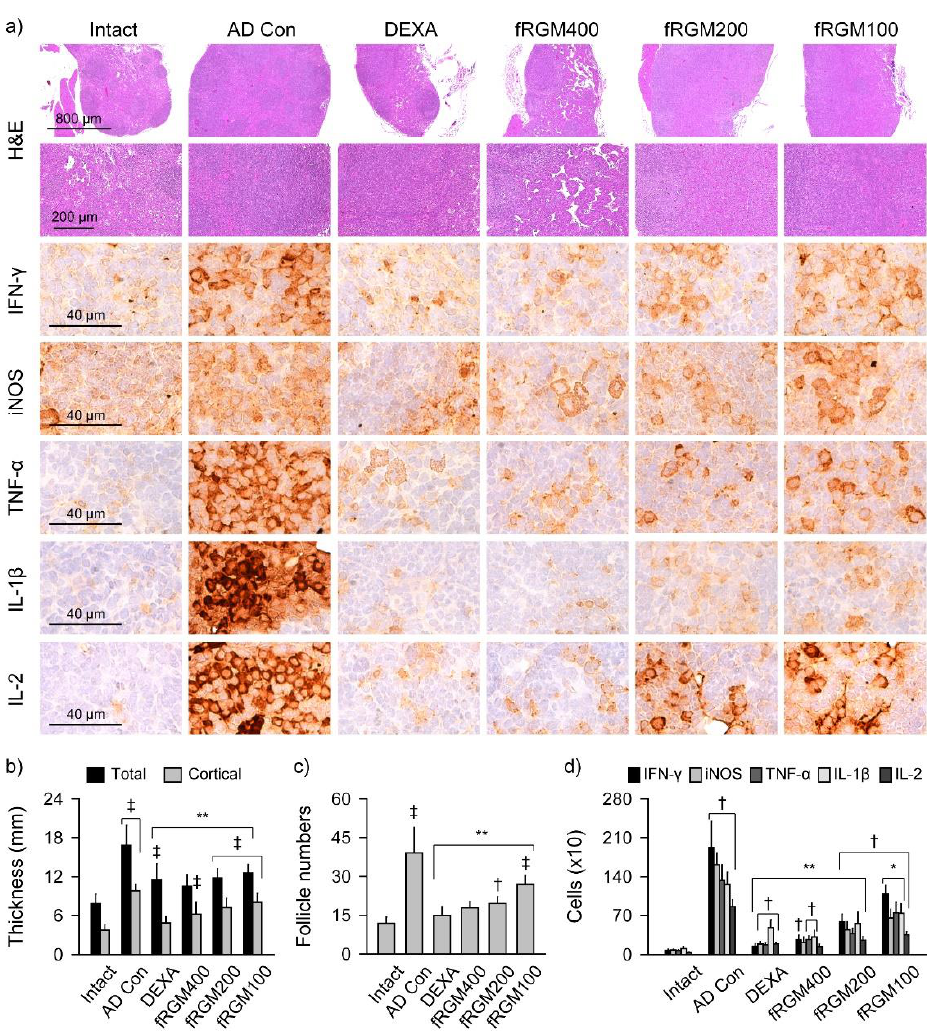
Figure 7. Histopathological changes in the lymph nodes of the AD-like model. ( a ) Representative images in H&E stain and immunostains for IFN- γ , iNOS-2, TNF- α , IL-1 β , and IL-2 in the lymph node. In H&E stains, the parenchyma in the upper is highly magnified in the lower. ( b ) Total and cortical thicknesses in the central region (mm). ( c ) Number of cortical follicles (follicles/mm 2 ). ( d ) Immunoreactive cells in the parenchyma (×10 cells/mm 2 ). Values are represented as means ± SDs. ‡: p < 0.01 and †: p < 0.05 vs. the Intact group; **: p < 0.01 and *: p < 0.05 vs. AD Con.